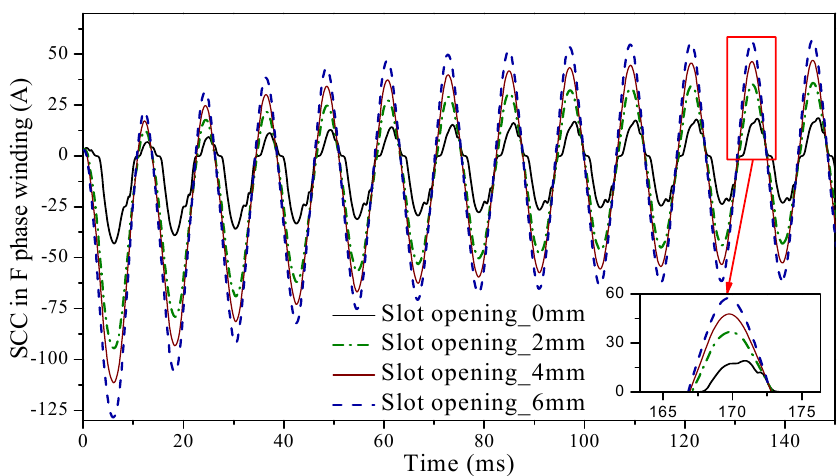
Figure 9. Waveforms of SCC in phase F